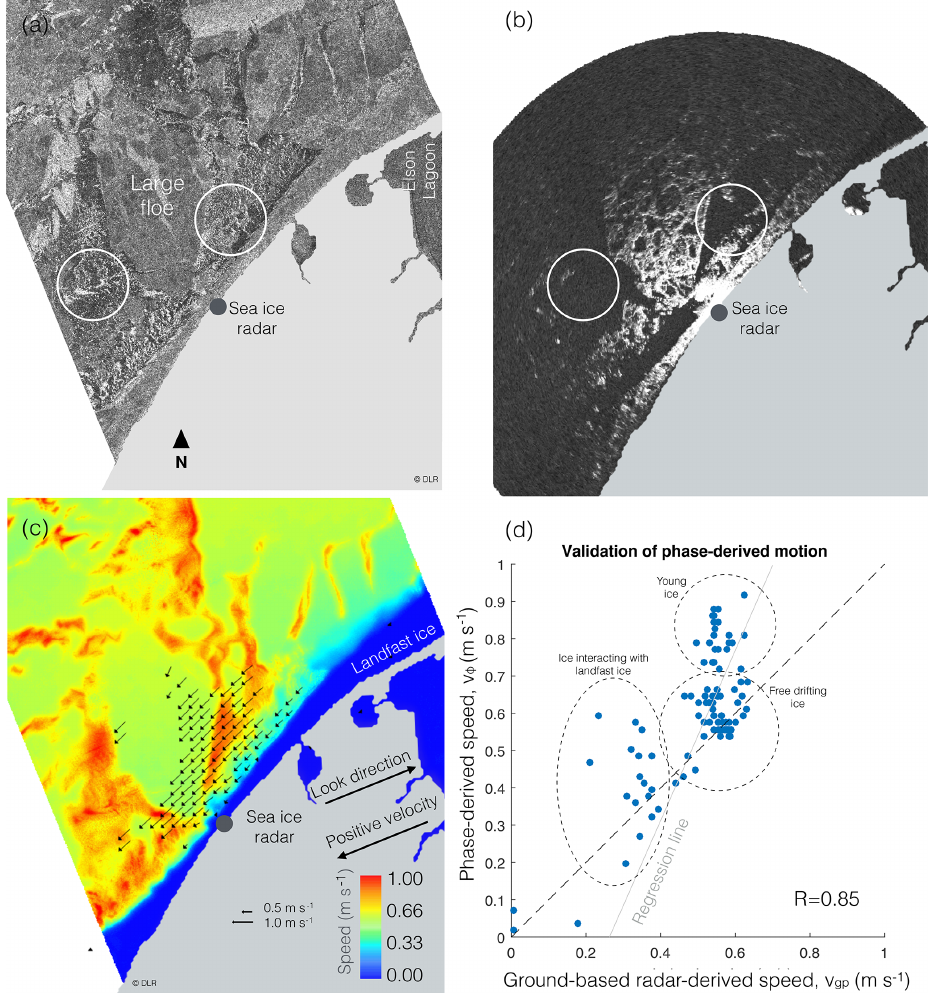
Figure 3. (a) TanDEM-X backscatter scene over Utqia˙gvik, Alaska, on 21 November 2015 03:19UTC. (b) Ground-based radar backscatter scene 21 November 2015 03:18UTC. Circles indicate areas of young ice, hence the reduced backscatter in (b) . (c) Interferometric phase- derived look-directional speed at 03:19UTC. Arrows represent speed derived from ground-based radar data averaged between 01:52 and 04:28UTC. Land is masked out in light gray. (d) Comparison between look-directional speed as evaluated using InSAR- and ground-based radar-derived speed. Circles in (d) indicate three types of drifting ice including floes interacting with landfast ice, free drifting floes, and young